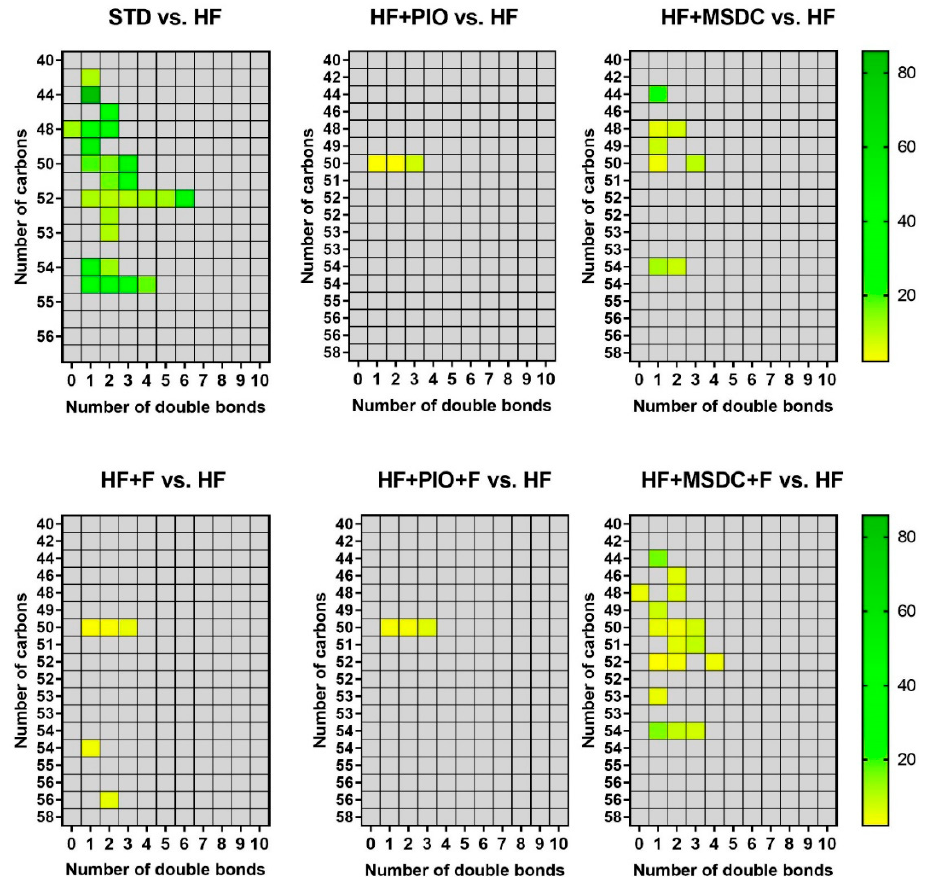
Figure 5. 2 H enrichment of various TAG species. In total, 62 deuterated TAG species detected using LC–MS analysis were considered. The ratio between mean enrichment of TAG in the respective intervention group and the HF mice (see the colored bar) was plotted only if the difference between groups was significant ( p ≤ 0.05, t -test). Data are plotted according to the length and saturation of TAG. Data are means ± SEMs ( n = 8). For designation of dietary groups, see Section 2.1.